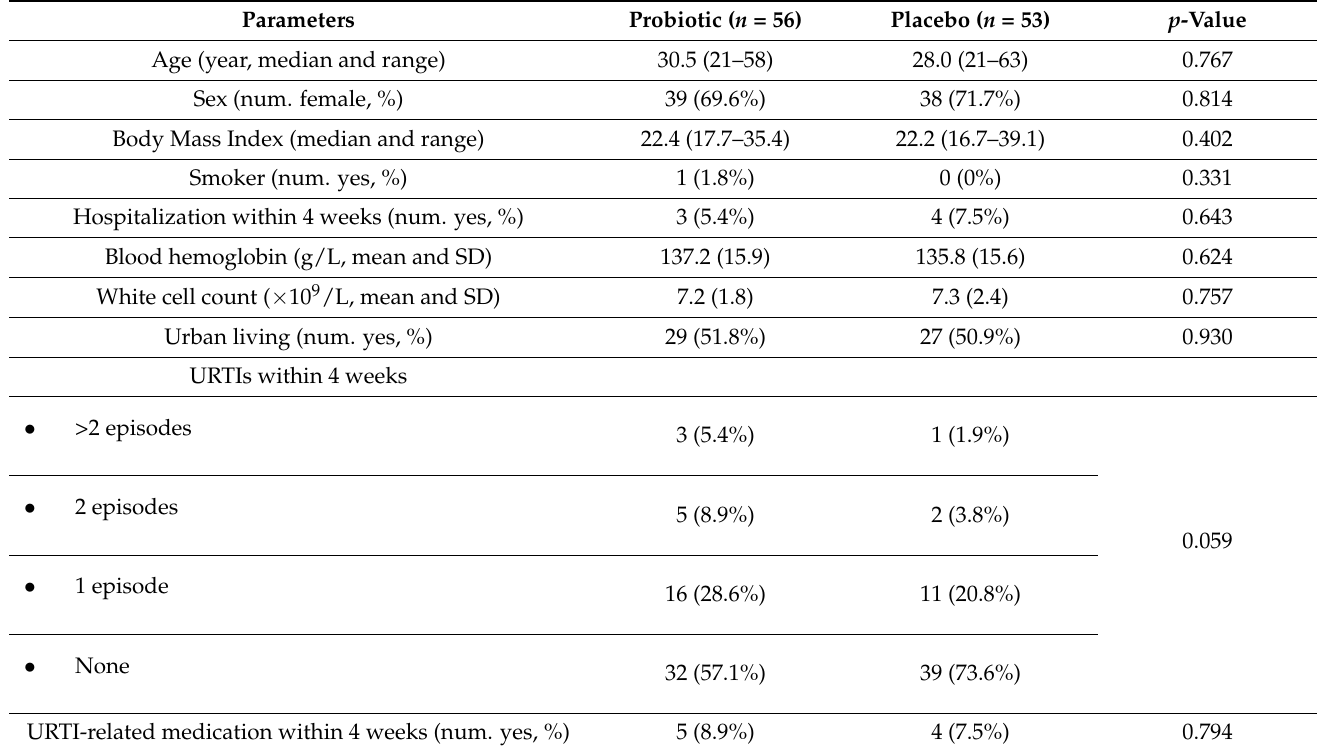
Table 1. Baseline characteristics of the 109 adult subjects randomly assigned to 12 weeks of double-blind treatment with either 10 9 CFU/day L. plantarum DR7 ( n = 56) or placebo ( n =